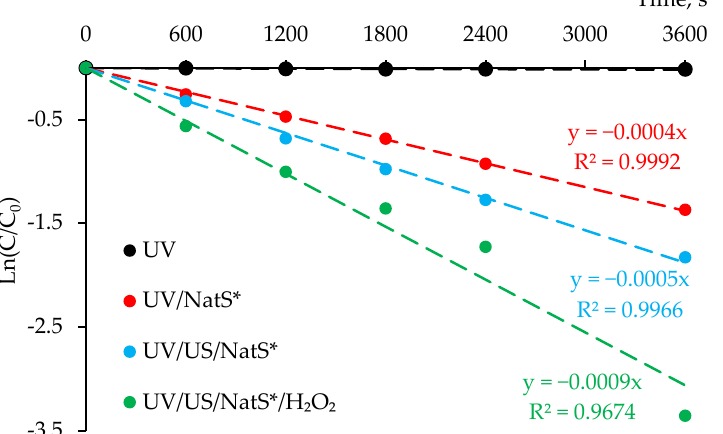
Figure 7. p CBA degradation plots under UVA LED (365 nm) and/or ultrasonic (1.7 MHz) irradiation using calcined natural sphalerite (NatS*, 900 °C, 1 g/L, 75 μ m sieve). [ p CBA] 0 = 20 μ M, [H 2 O 2 ] 0 = 1 mM.